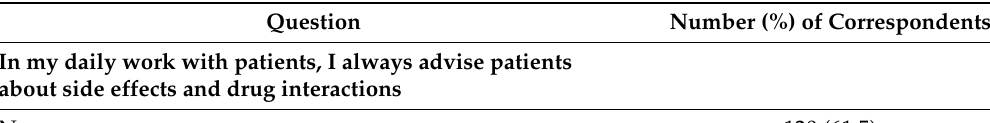
Table 4. Informing patients about side effects and drug